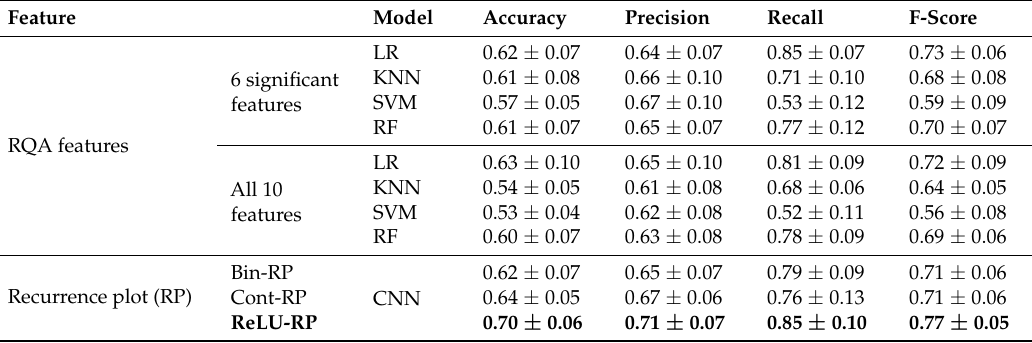
Table 3. Drowsy/awake classification performance using ECG strap signals; performance measures were calculated based on 10-fold cross-validation. LR—logistic regression; KNN—K-nearest neighbor; SVM—support vector machine; and RF—random